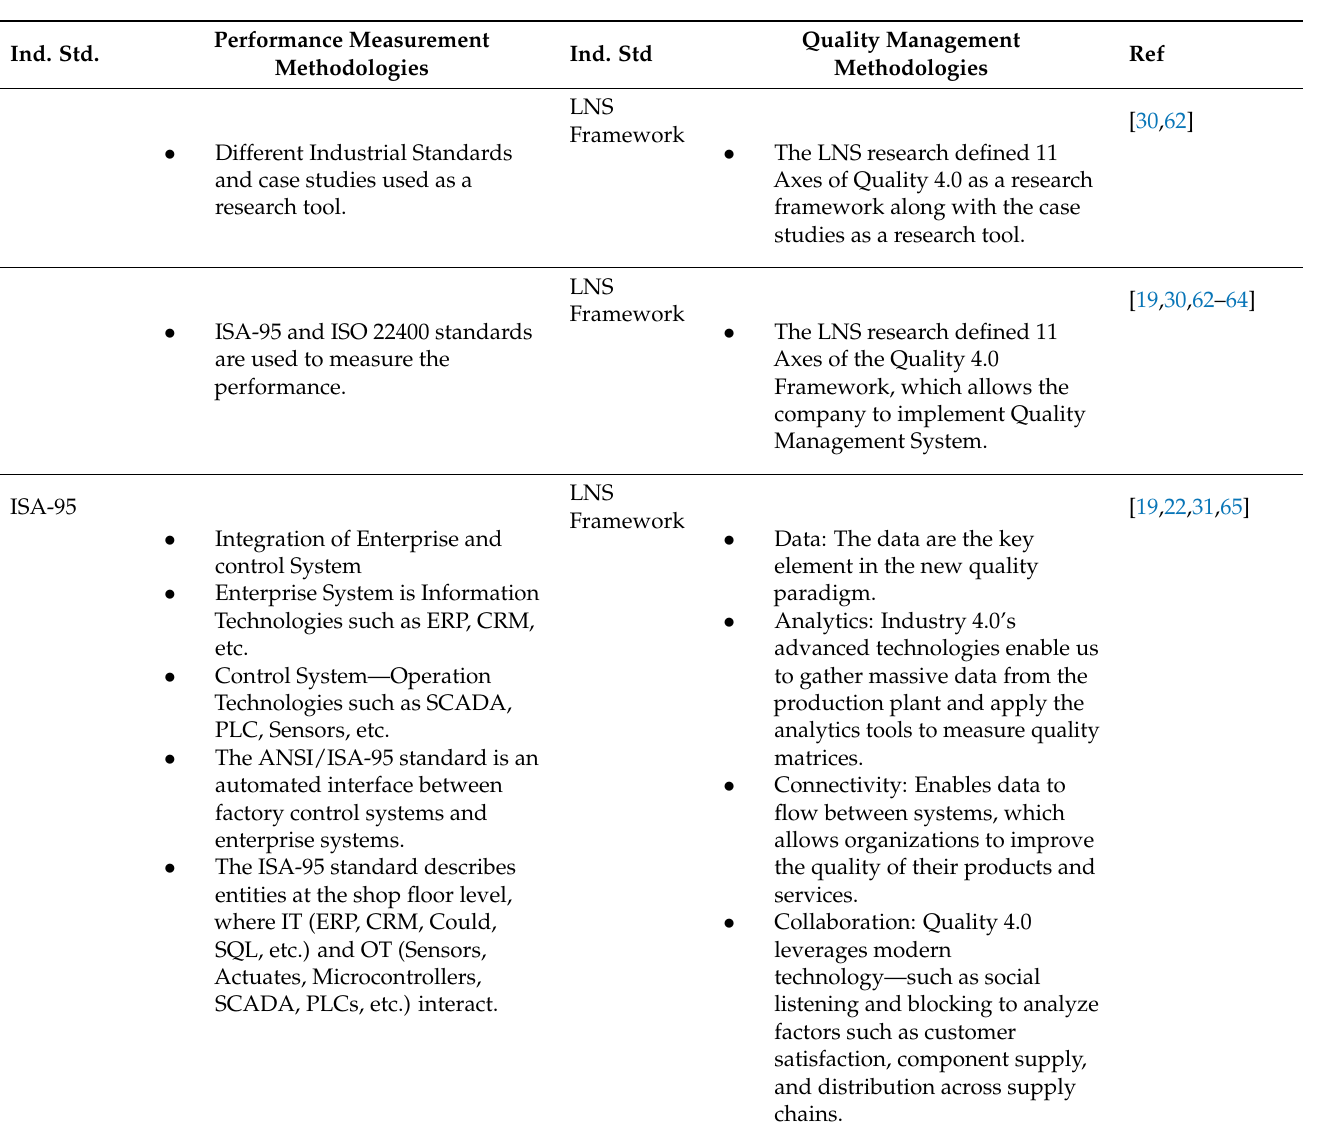
Table 1. Performance measurement and quality management